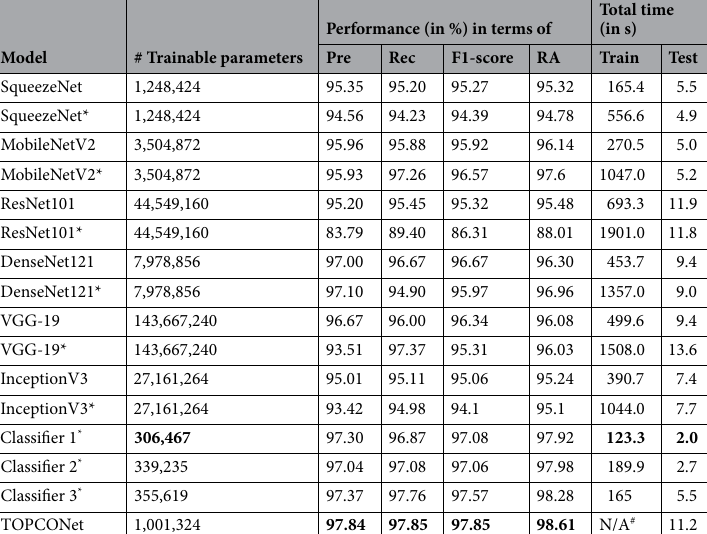
training from the scratch. In the transfer learning approach, we load the pre-trained weights of the respective CNN models which are obtained after training the models on the ImageNet dataset. Subsequently, using the loaded weights we fine-tune the models on both datasets. To maintain uniformity during performance compari- son, the total number of epochs used is 15 for both state-of-the-art CNN models and the proposed classifiers.